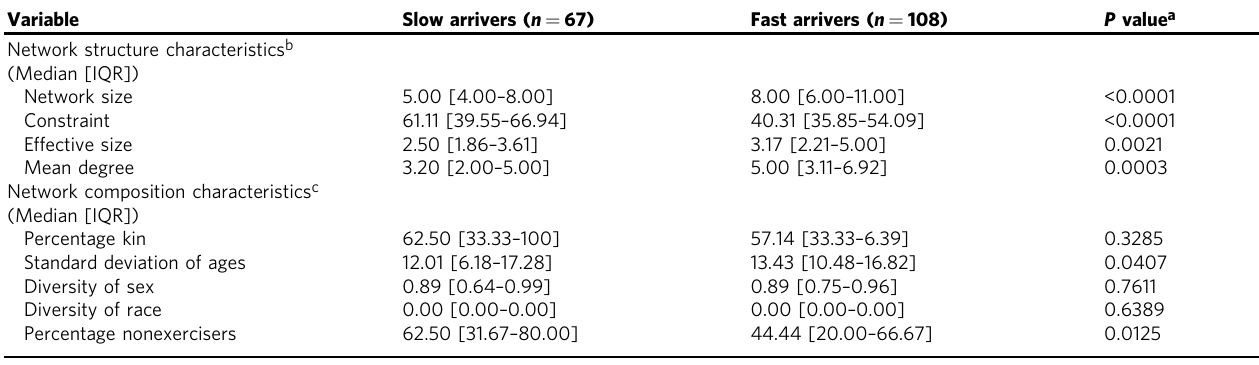
Table 2 Network characteristics of slow and fast arrivers, unadjusted Variable Slow arrivers ( n = 67)